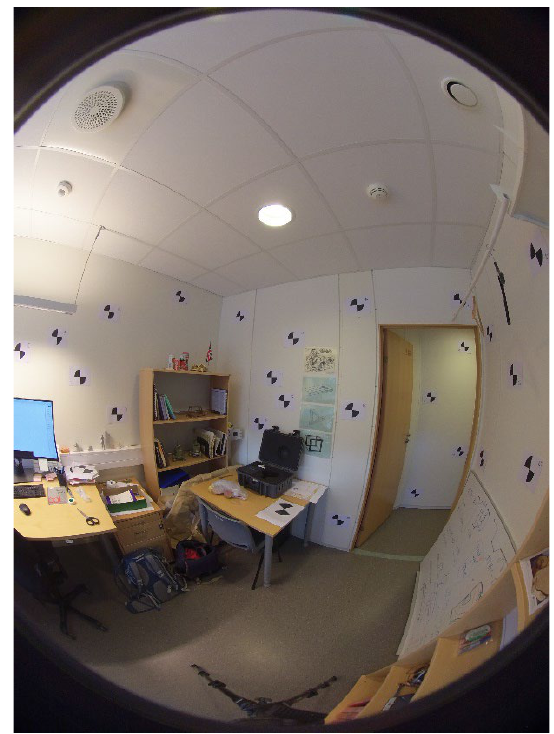
Figure 2. A fisheye image taken at the test site.